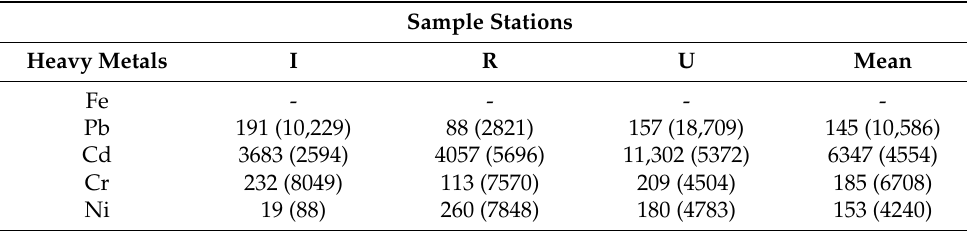
Table 10. Enrichment Factors ( EF ) for the soil and Vernonia amygdalina samples.